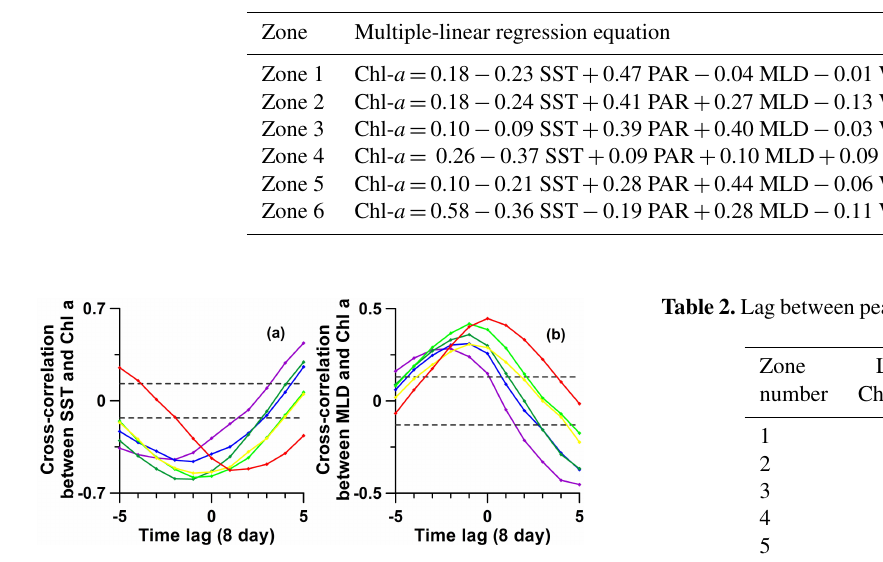
Table 1. Multiple-linear regression analysis.